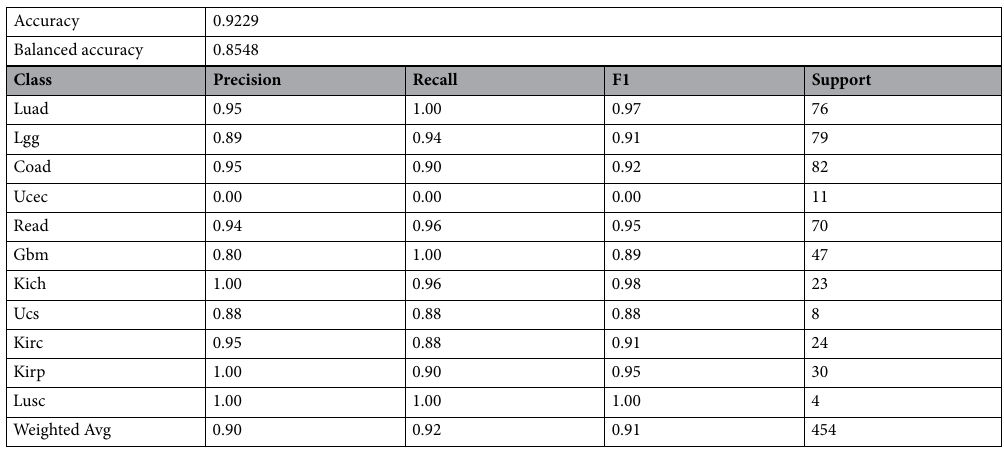
Table 3. Neoplastic subtype classifier.